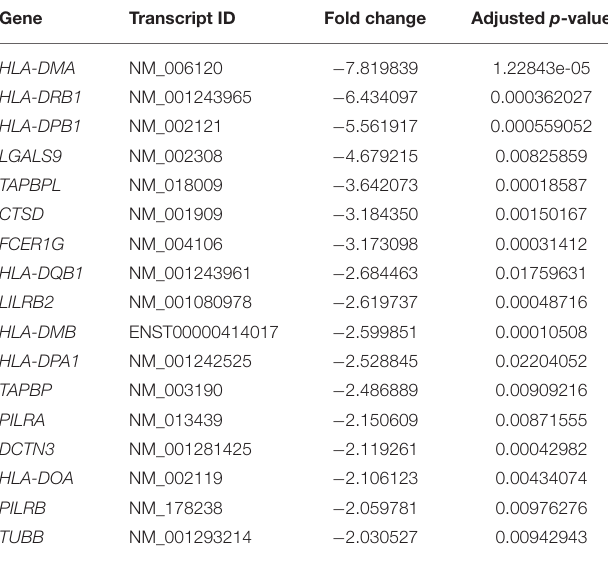
TABLE 3 | Downregulated DEGs associated with the MHC protein complex.